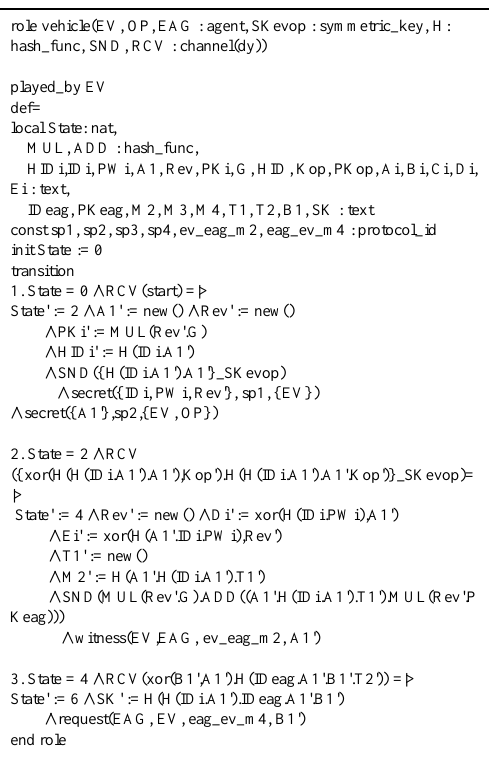
Figure 8. Code of session and environments.